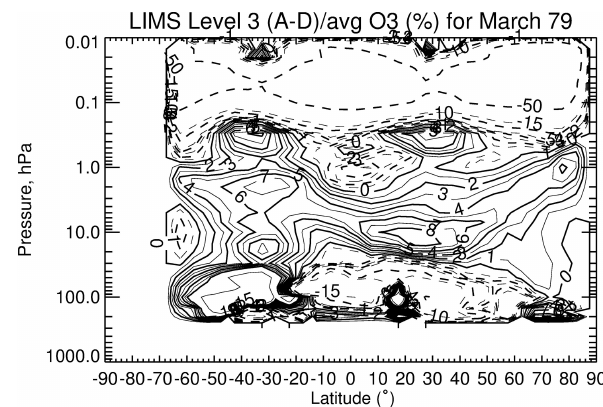
Figure 6. LIMS V6 level 3 monthly zonal mean ( A − D ) ozone dif- ferences divided by average ozone (and given in %) for March 1979. Solid contours are positive and CI is 1% from 0 to 10, 5% from 10 to 15, and then skips to the 50%